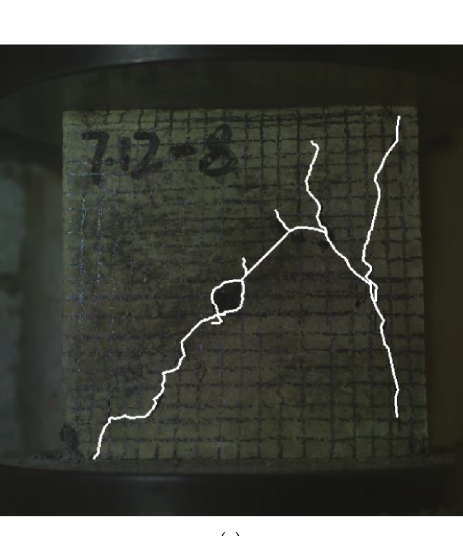
Figure 12: Schematic diagram of three coalescence modes of specimen containing two flaws: (a) shear mode, (b) mixed mode, and (c) traction